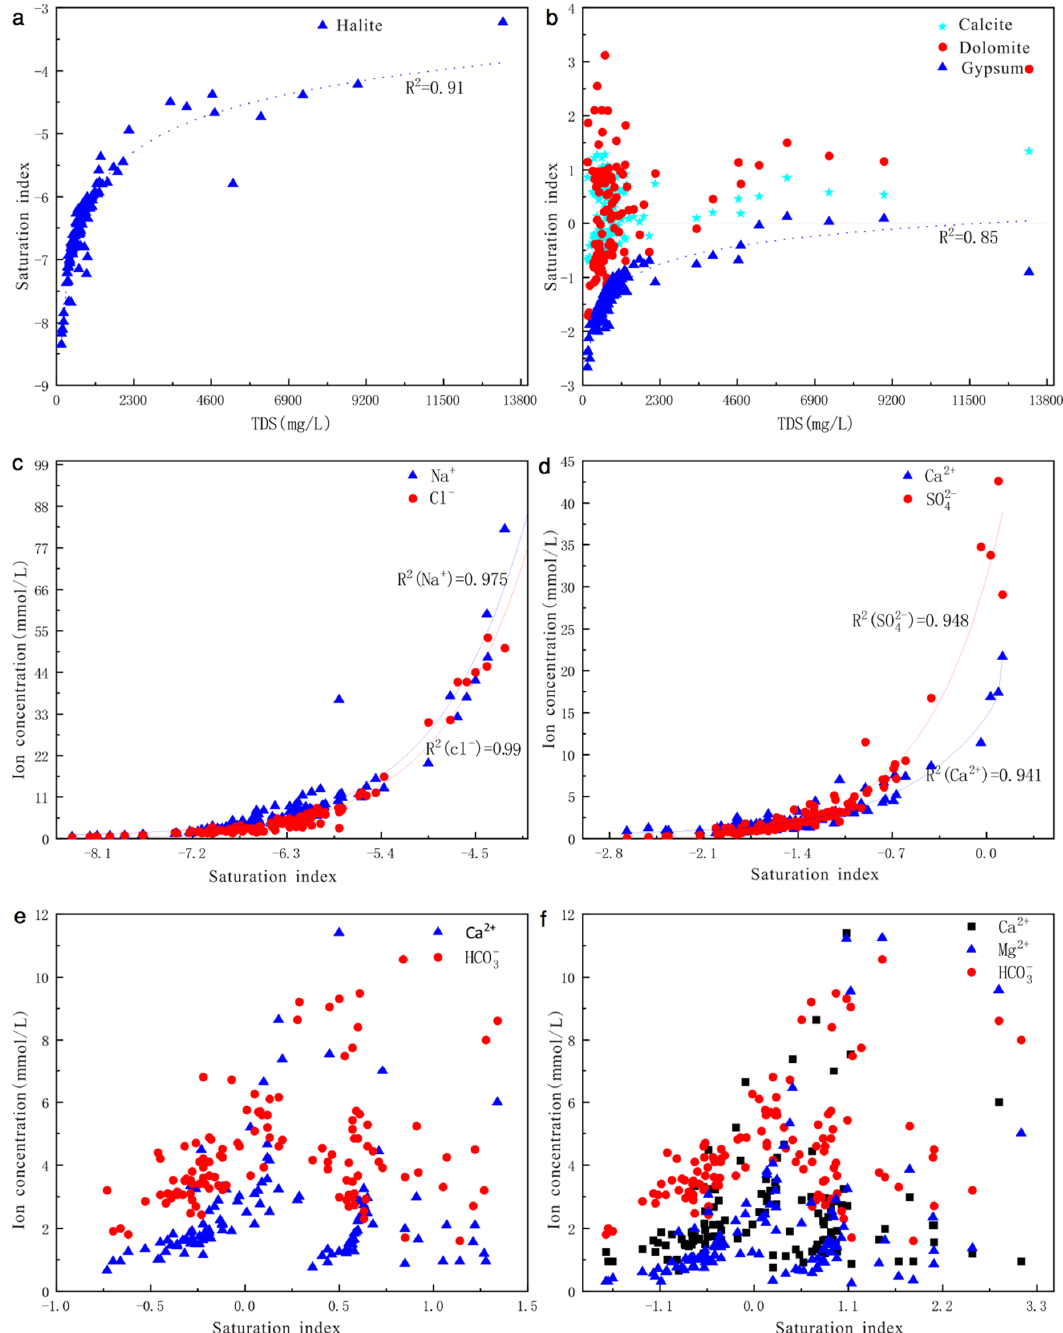
Figure 7. Saturation indices plots with selected minerals versus TDS or ion concentration. ( a ) SI halite vs. TDS, ( b ) SI gypsum , SI calcite , SI dolomite vs. TDS, ( c ) Na + , Cl − vs. SI halite , ( d ) Ca 2+ ,SO 42 − vs. SI gypsum , ( e ) Ca 2+ , HCO 3 − vs. SI calcite , ( f ) Ca 2+ ,Mg 2+ ,HCO 3 − vs. SI dolomite.